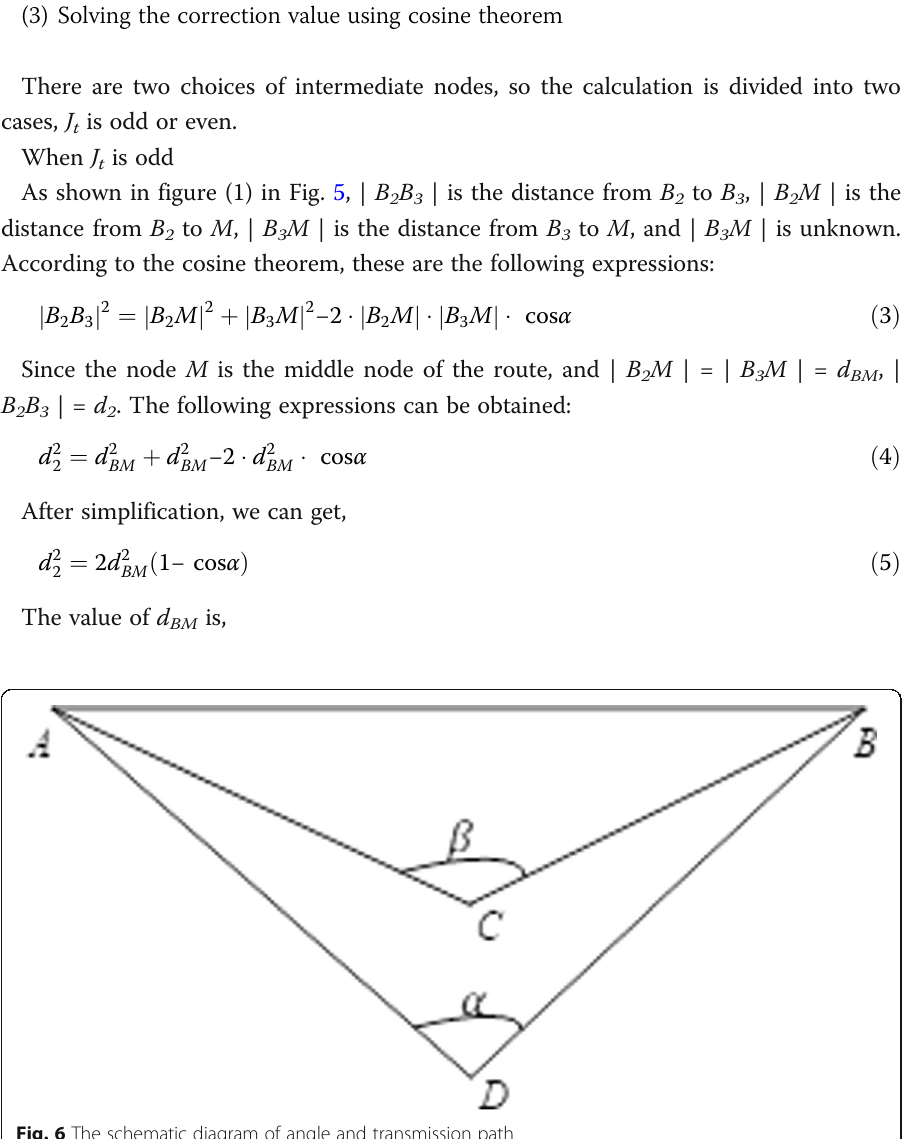
Fig. 6 The schematic diagram of angle and transmission